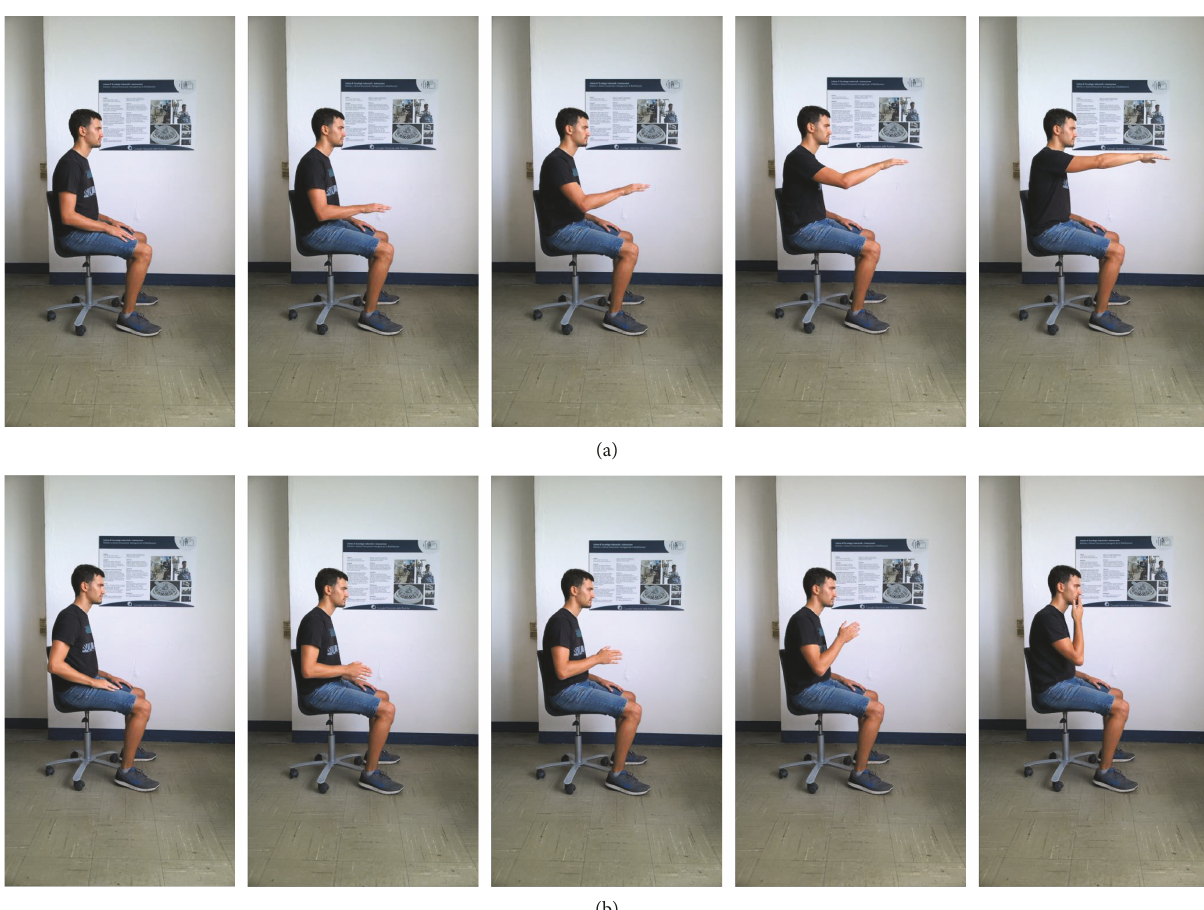
Figure 2: (a) The reaching movement (RM) and (b) hand-to-mouth movement